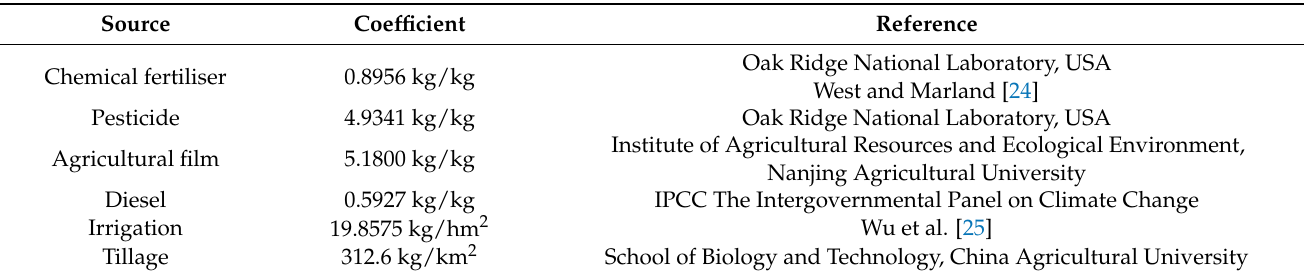
Table 1. Agricultural carbon emission sources, coefficients, and